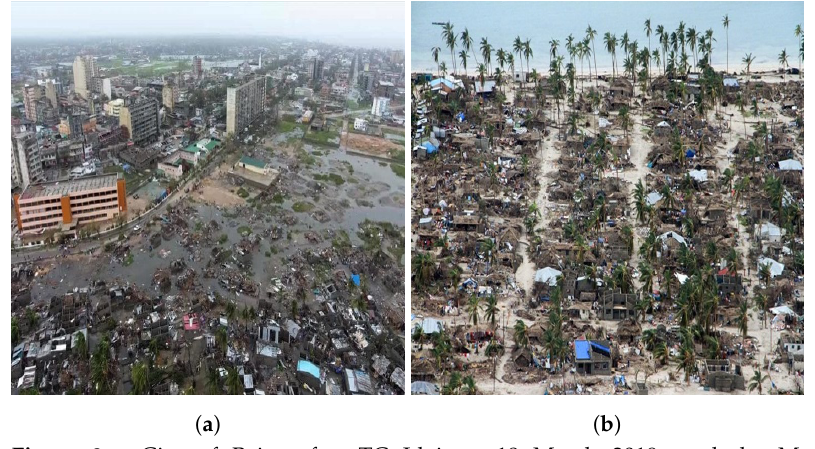
Figure 3. City of Beira after TC Idai on 18 March 2019, and the Macomia district af- ter TC Kenneth on 27 April 2019.